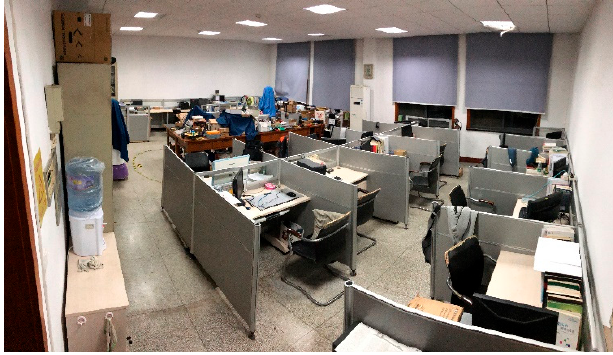
Figure 2. Room-scale experimental environment.